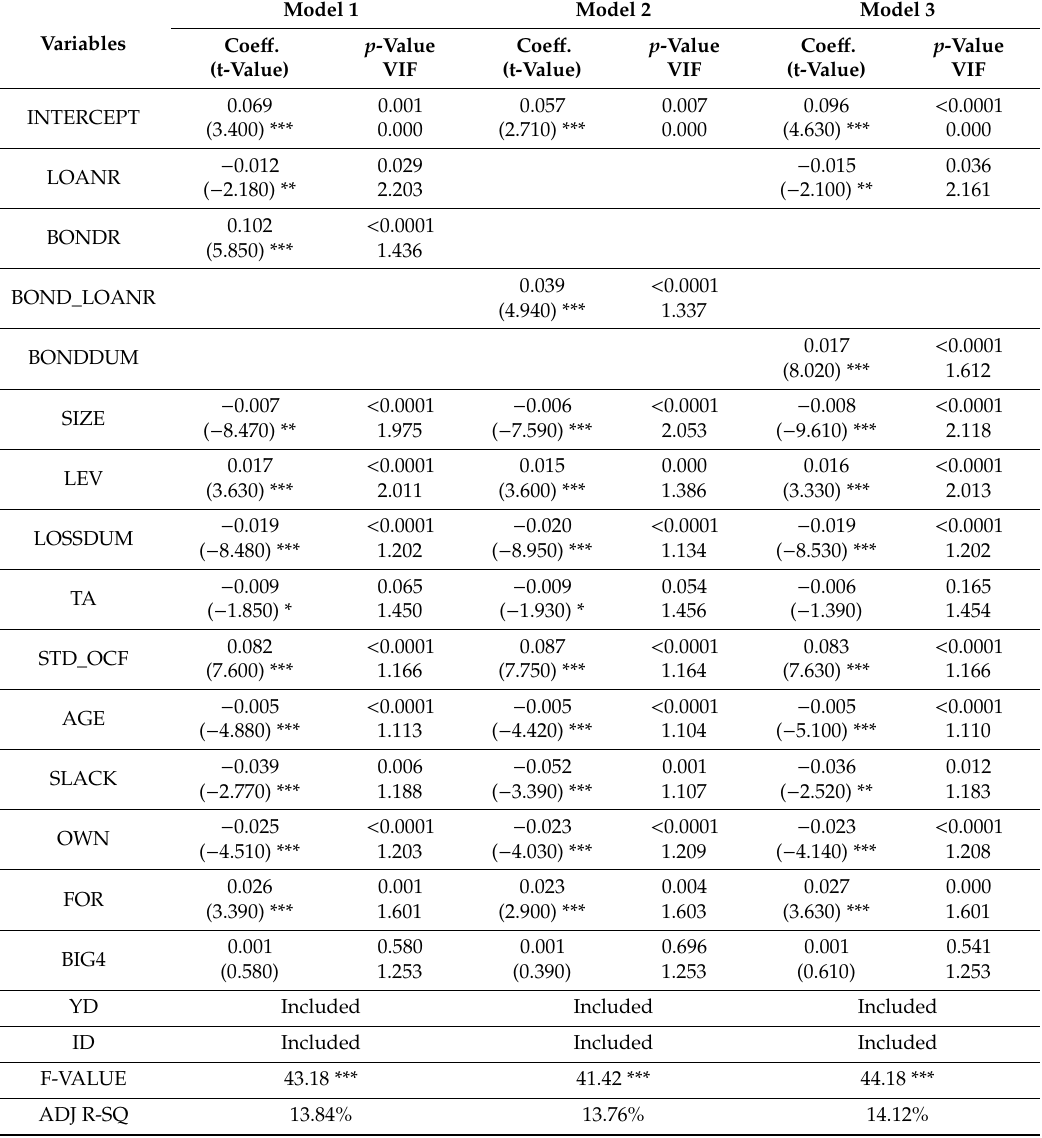
Table 5. Debt origin and investment e ffi ciency: total sample (n =